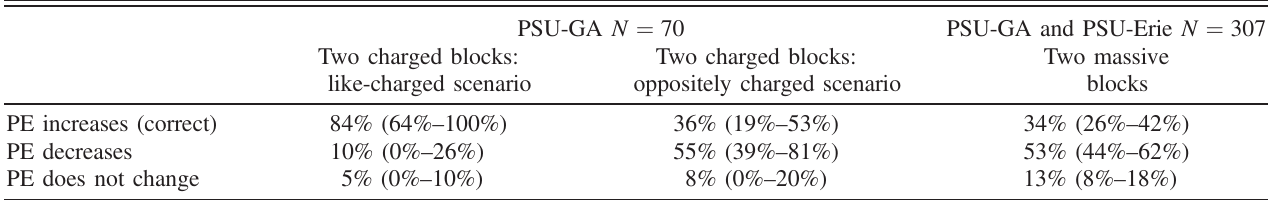
TABLE I: Student responses regarding potential energy (PE) on the two charged blocks and two massive blocks problems. Results were obtained after interactive instruction on the relevant topics. Values given are the mean across four and nine sections for the two charged blocks and the two massive blocks problems, respectively. Values in parentheses reflect the 95% confidence interval based on variances among the samples. In all tables, the percentages include both students who did and who did not provide correct